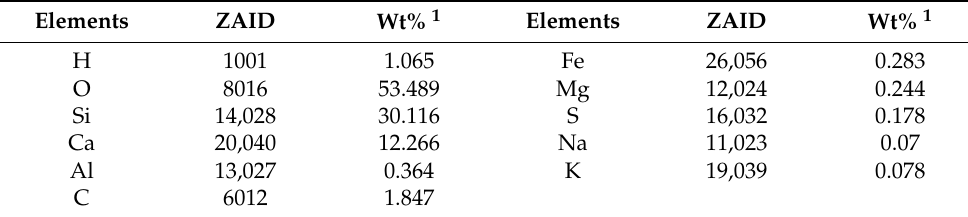
Table 1. Weight percentage of the concrete constituents